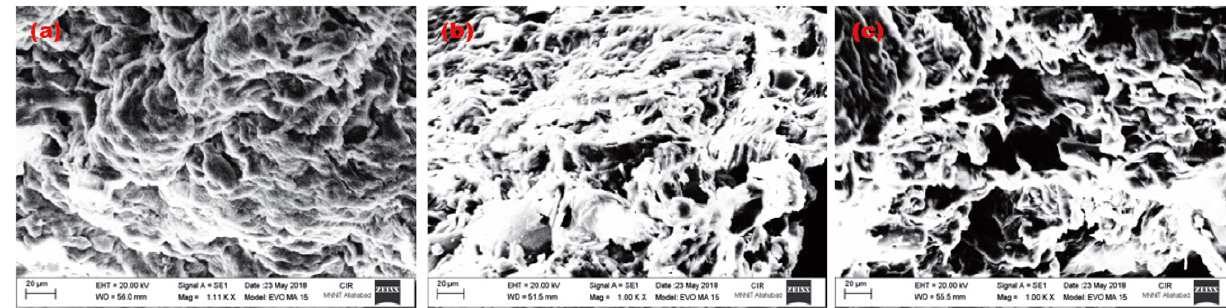
Figure 4. SEM micrographs of (a) H 2 SO 4 modified slag; (b) NaOH modified slag; (c) native